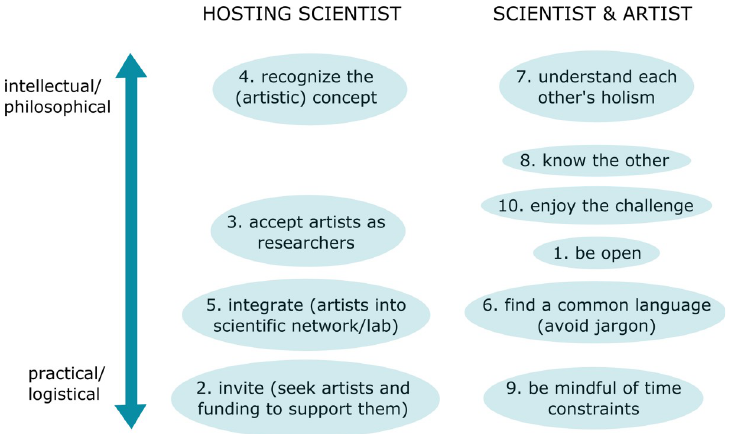
Fig 1. Summary of the 10 rules, arrayed from intellectual/philosophical to practical/logistical and divided into rules more applicable to the hosting science lab and rules relevant for both the hosting lab and the artist.